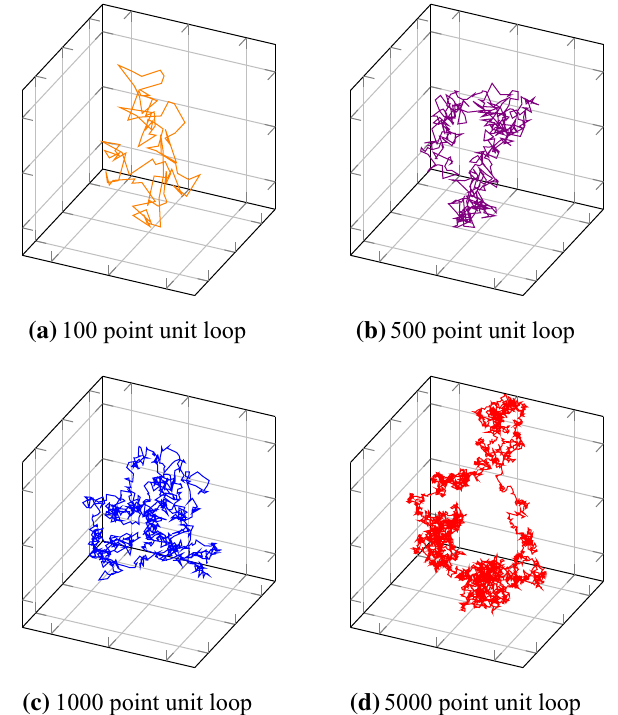
Fig. 4 Gaussian distributed closed unit loops representative of scalar field fluctuation generated using v-loop methodology. Algorithm will generate ensemble of n L unit loops to be scaled and applied at each geometric point of interest in a physical